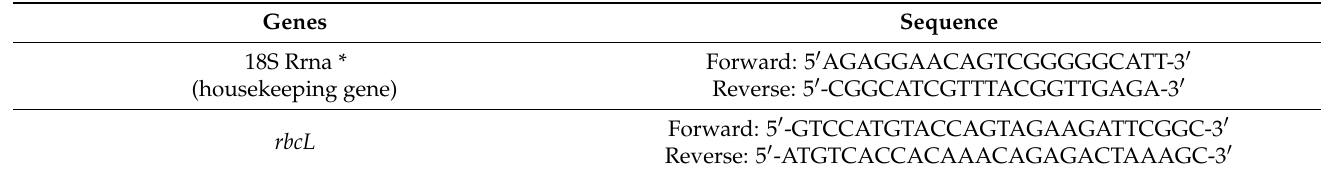
Table 1. Primers used in this